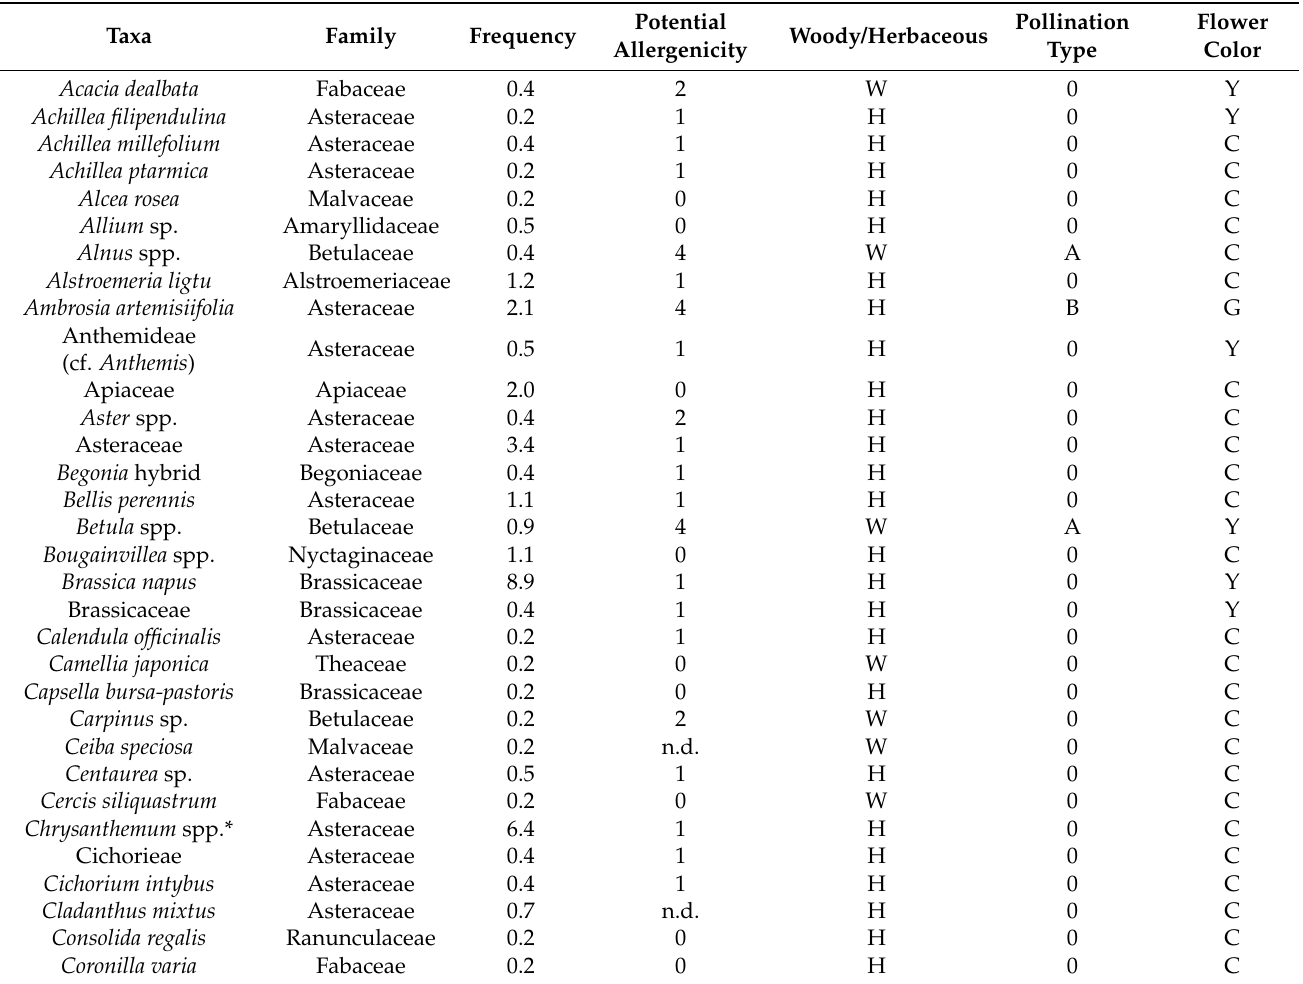
Table 2. Plant taxa used in the illustrations of allergy-related marketing materials. Frequency: